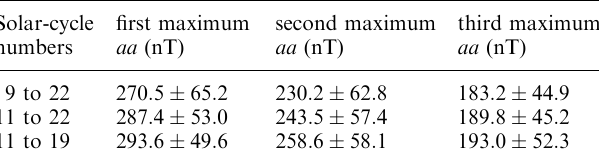
cycles 11 to 22 (first number) and 11–19 (second number). (Relative dispersion derived by dividing the standard deviation by the mode.)